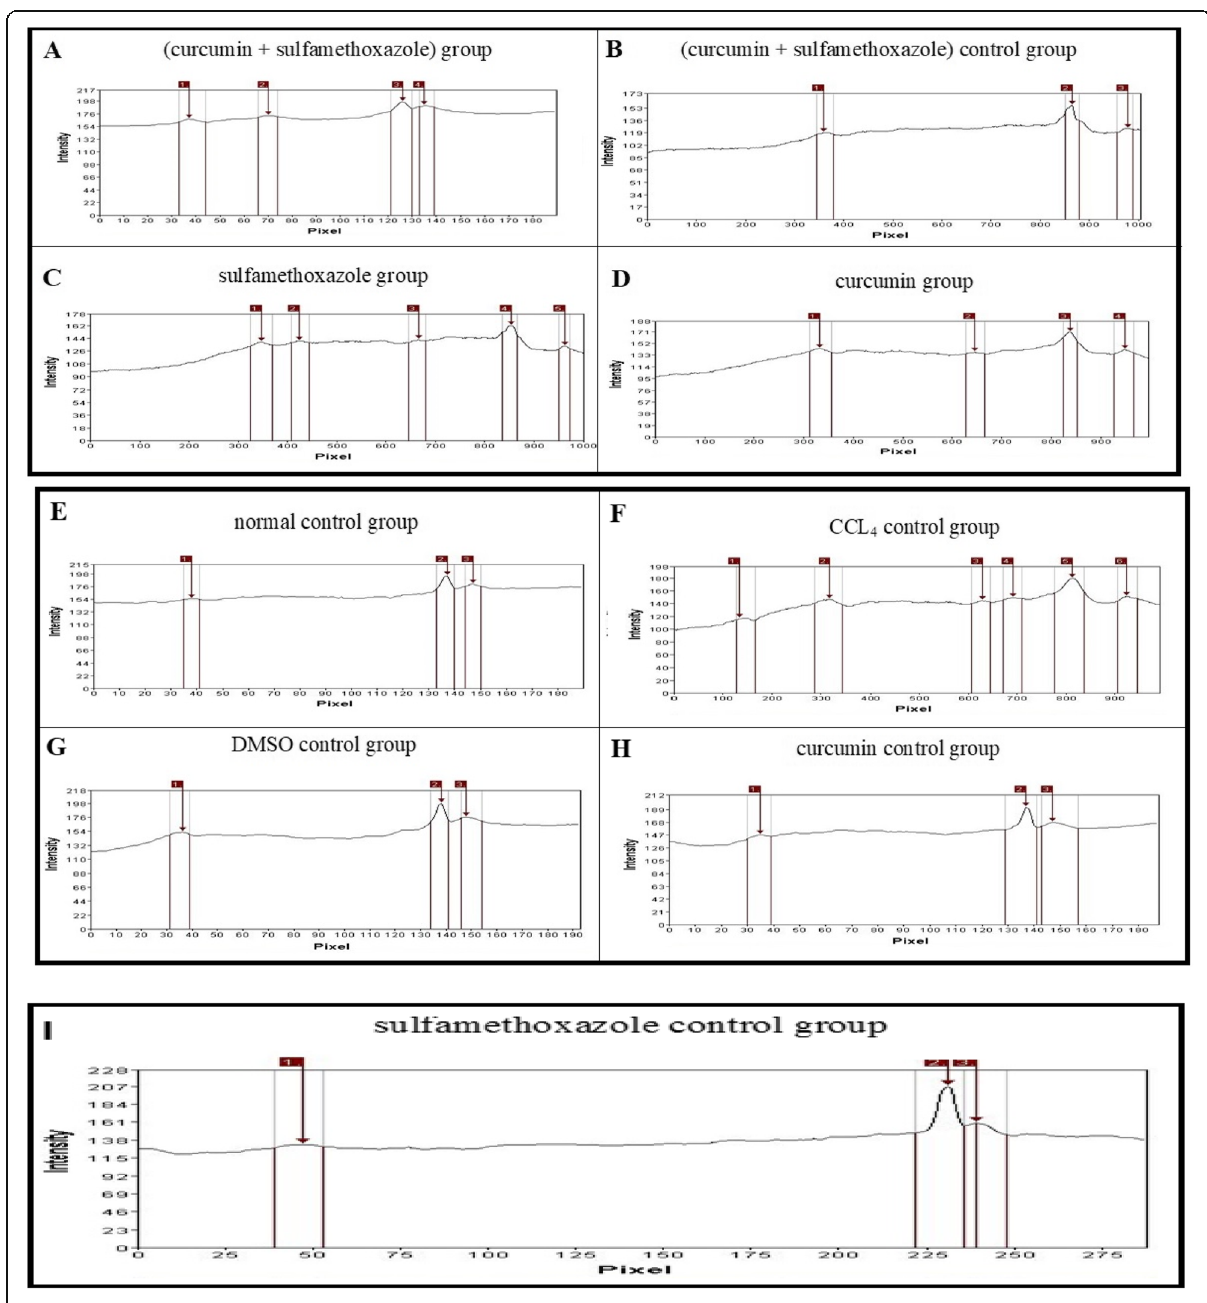
Fig. 10 Gel Pro analysis of protein pattern of liver tissue samples by SDS electrophoresis SDS of combination (curcumin + sulfamethoxazole) group ( a ), (curcumin + sulfamethoxazole) control group ( b ), sulfamethoxazole group ( c ), curcumin group ( d ), normal control group ( e ), CCl 4 control group ( f ), DMSO control group ( g ) curcumin control group ( h ), sulfamethoxazole control group ( i